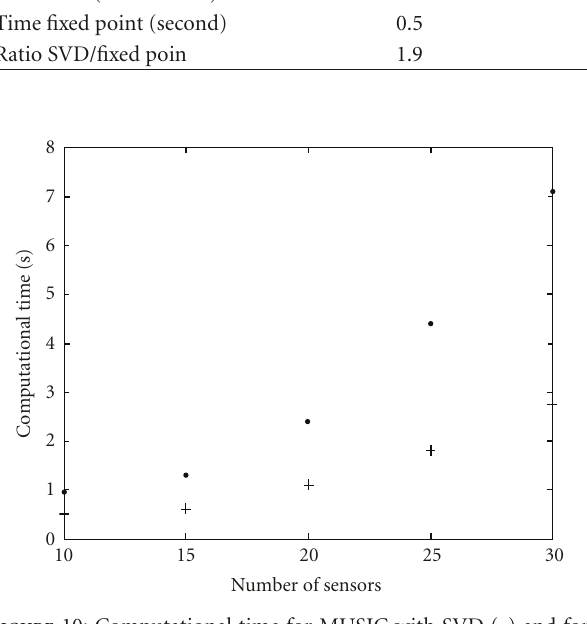
Figure 12: Pseudospectrum of MUSIC obtained using fixed point.